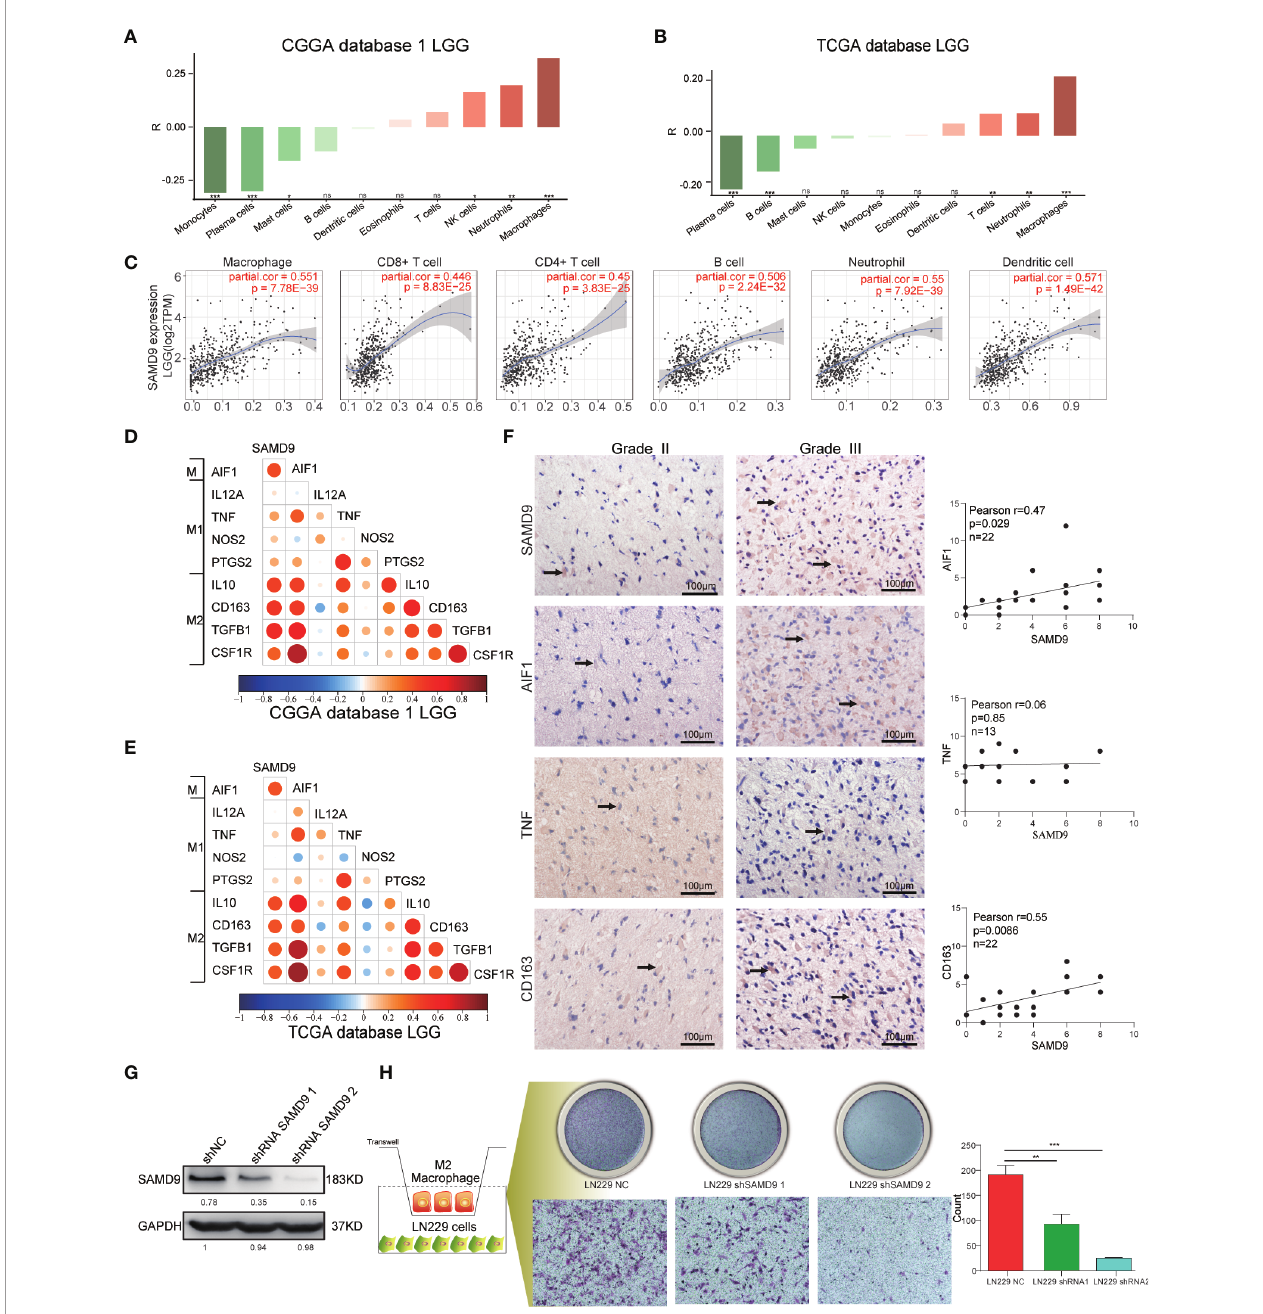
FIGURE 7 | SAMD9 enrichment with M2 macrophages in LGG. (A, B) The correlation between SAMD9 and ten types of in fi ltrating immune cells (B cells, plasma cells, T cells, NK cells, monocytes, macrophages, dendritic cells, mast cells, eosinophils, neutrophils) in CGGA database 1 LGG, Correlation between SAMD9 and macrophages in CGGA database 1 LGG (R = 0.32, p = 9.6E-06) and in TCGA database LGG (R = 0.34, p = 1.1E-13). (C) Correlation between SAMD9 and the six immune cell types (B cells, CD4 T cells, CD8 T cells, neutrophils, macrophages and dendritic cells) on TIMER algorithm, macrophages, partial.cor = 0.551, p = 7.78E-39. (D, E) Nine classical phenotype markers of M ( AIF1 ), M1 ( IL12A , TNF, NOS2, PTGS2 ) and M2 ( IL10 , CCL163 , TGFB1, CSF1R) were analyzed in CGGA and TCGA database, Color depth and circle square represent the degrees of correlation. (F) SAMD9, AIF1, CD163 and TNF expression levels in glioma specimens determined by IHC analysis in grade II and III. Scale bar = 100 m m. Correlation analysis of SAMD9 and related proteins immunohistochemical scores. X-axis, SAMD9 staining score; y-axis, AIF1, CD163 and TNF staining score; Correlation coef fi cient between SAMD9 and AIF1, r = 0.47; p = 0.029. Correlation coef fi cient between SAMD9 and TNF, r = 0.06; p = 0.85. Correlation coef fi cient between SAMD9 and CD163, r = 0.55; p =0.0086. (G) Western blots of LN229 cells with stable expression of shSAMD9. (H) In fi ltration of M2 macrophage in LN229 NC (left), LN229 shSAMD9 1 (middle), LN229 shSAMD9 2 (right). LN229 NC & LN229 shSAMD9 1, **. LN229 NC & LN229 shSAMD9 2, ***.*, **, ***, **** and ns indicate p < 0.05, p < 0.01, p < 0.001, p < 0.0001 and no signi fi cance,